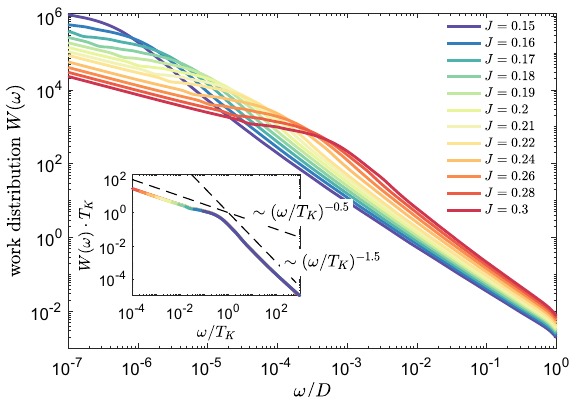
Figure 3. The work distribution calculated for quantum quench in the coupling strength J 1 ≡ J , starting from J = 0 to the value shown in the legend, while J 2 = 0 . The inset presents the rescaled work distribution W (ω) · T K plotted as a function of ω/ T K . We find the scaling W (ω) ∼ ω − 0.5 for ω < T K and W (ω) ∼ ω − 1.5 for ω > T K . The other parameters are the same as in Fig.